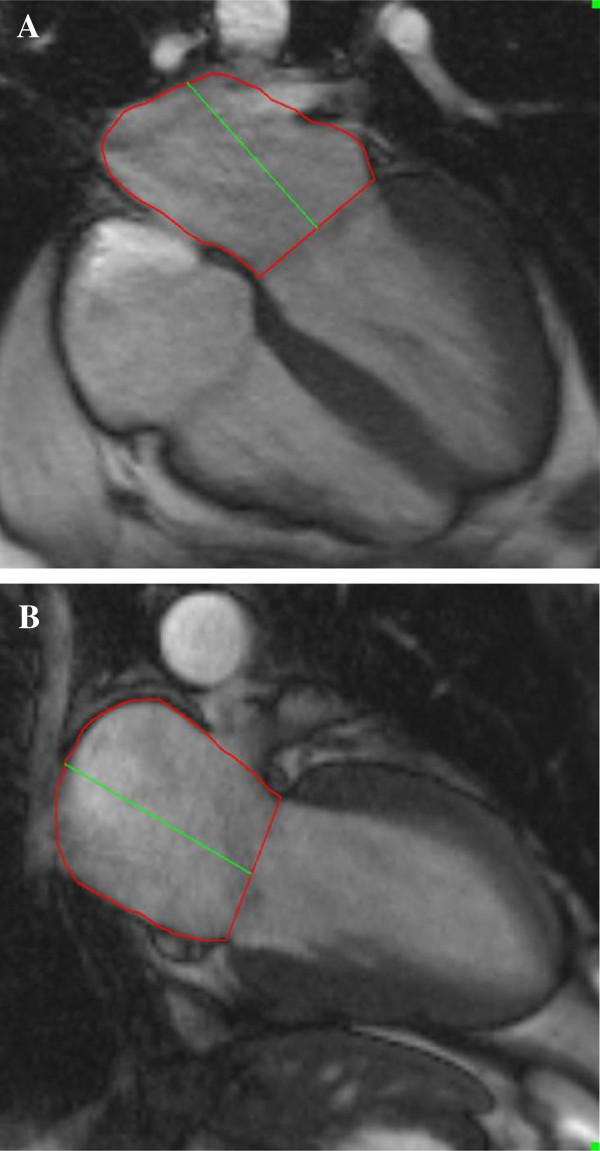
Left atrial area and length assessment using the 4 (A) and 2 (B) chamber views at left ventricular end systole.